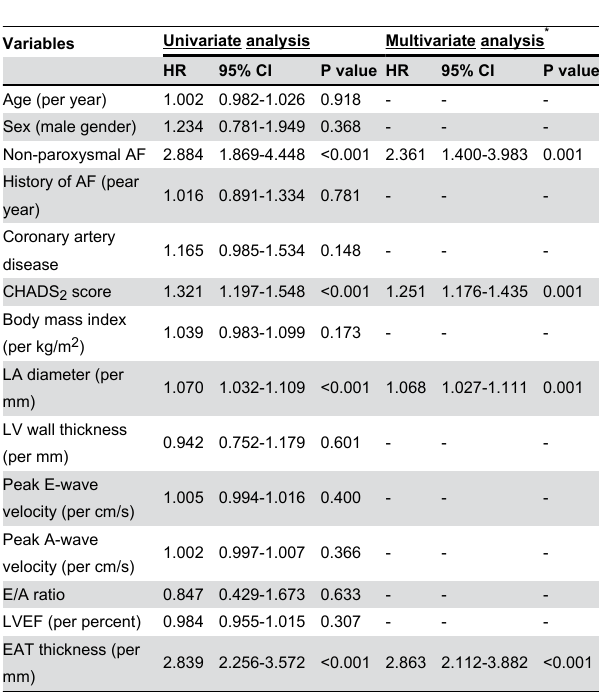
Table 1. Baseline characteristics of the patients (n=283). Table 2. Cox regression analysis for predictors of